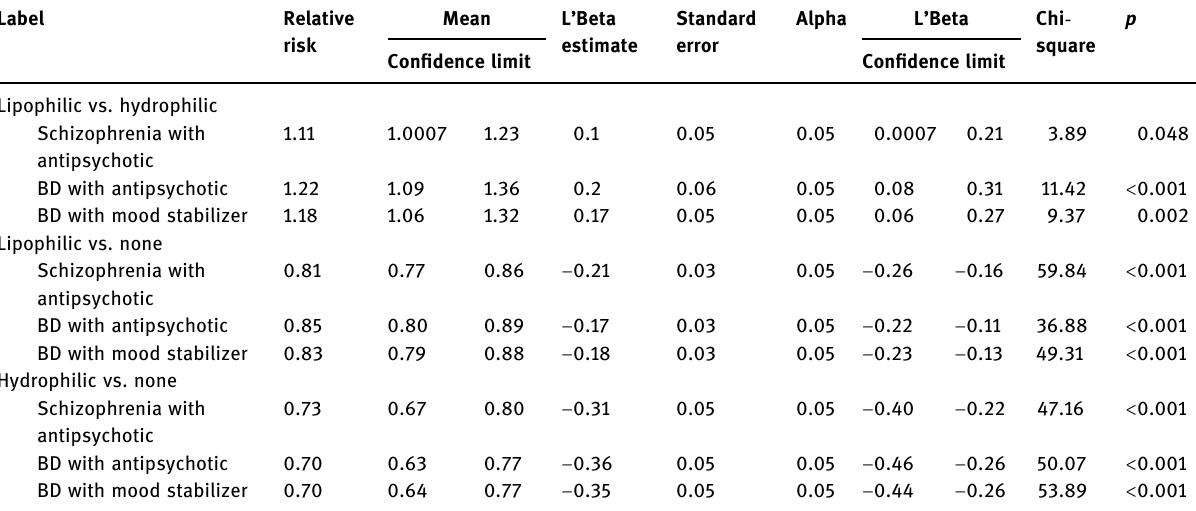
Table 4: Inpatient psychiatric hospitalization in individuals with schizophrenia and bipolar disorder; comparison between lipophilic, hydrophilic, and no statin groups Label